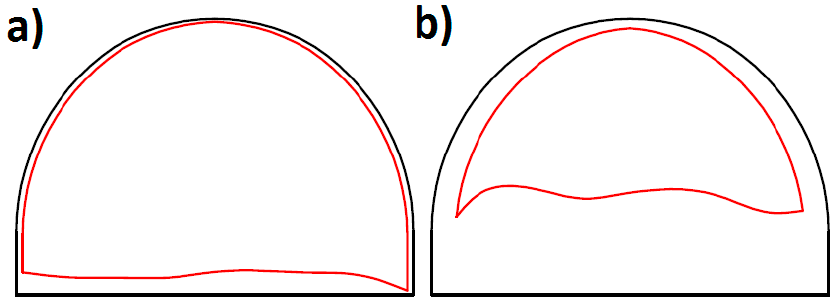
Figure 5. Maingate D-2 convergence: ( a ) station at ch. 930 m; ( b ) station at ch. 757 m.